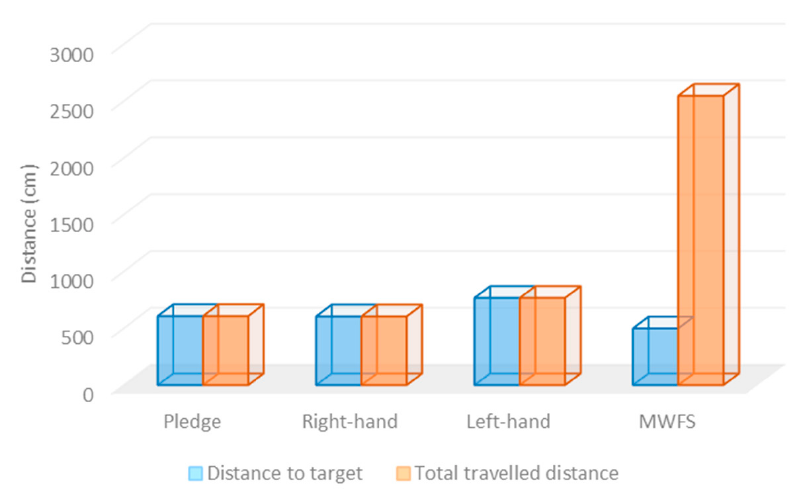
Figure 13. The total traveled distance of the solver robot for 4 algorithms in testbed # 3.